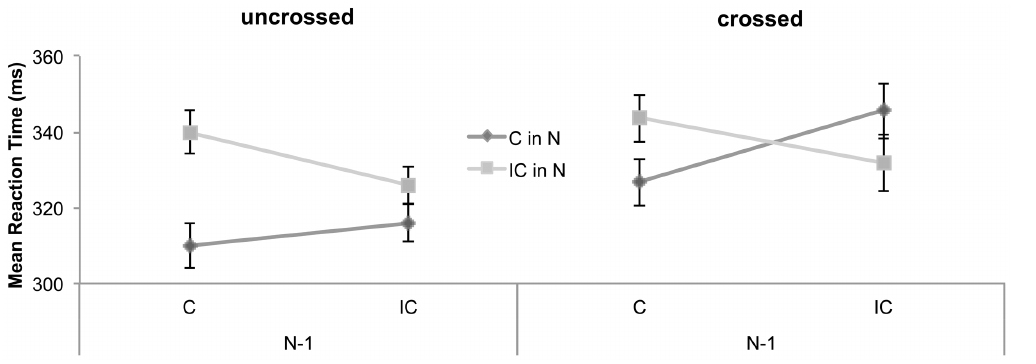
Figure 3. Sequential trial-by-trial dependencies. Mean reaction time in milliseconds (ms) of the congenitally-blind participants as a function of compatibility in trial N, depending on the compatibility (C: Compatible and IC: Incompatible) of the previous trials (N–1) for the uncrossed hand (left panel) and the crossed hand condition (right panel). Error bars depict the standard error of the mean difference.